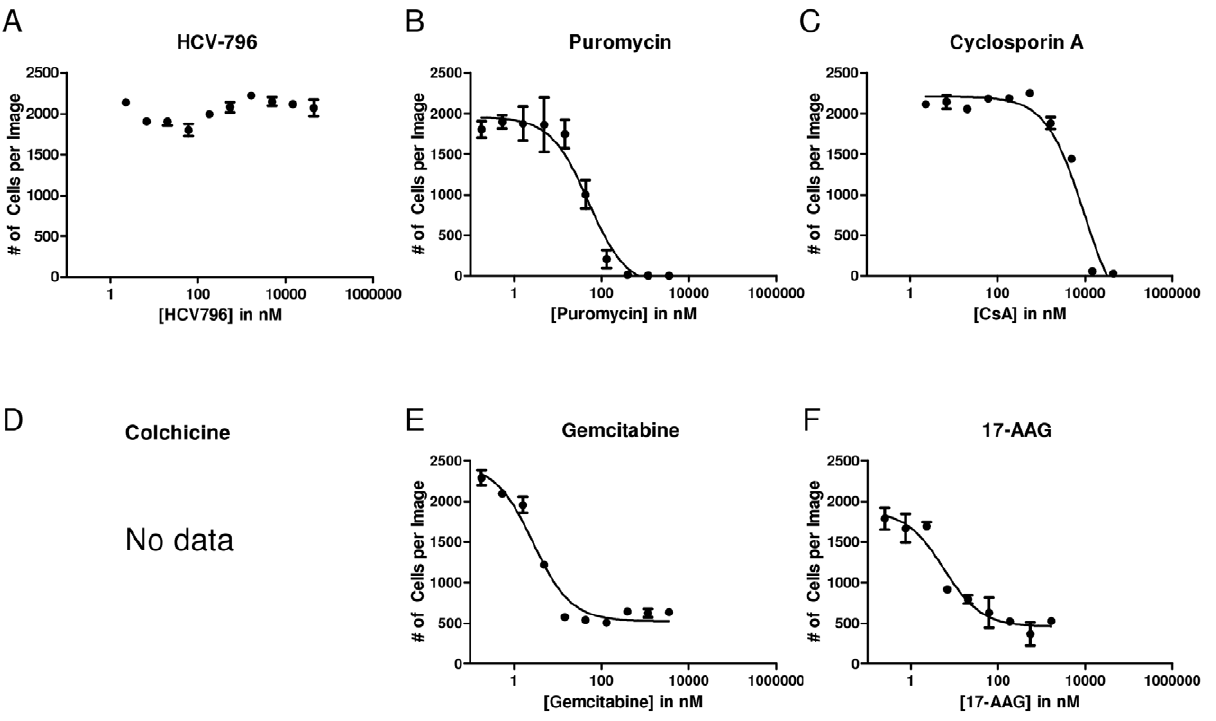
Figure 3. Effect of 17-AAG and CsA on cellular viability determined by cell count. Cell viability (measured by direct microscopic quantification of Hoechst-stained nuclei) was assessed as a function of dose in a three day assay for the following molecules: (A) the HCV polymerase inhibitor HCV-796, (B) the ribosomal inhibitor puromycin, (C) the cyclophilin inhibitor CsA, (D) the microtubule inhibitor colchicine, (E) the anti- metabolite gemcitabine, and (F) the HSP90 inhibitor 17-AAG. Colchicine dramatically altered cellular morphology, preventing an accurate cell count.